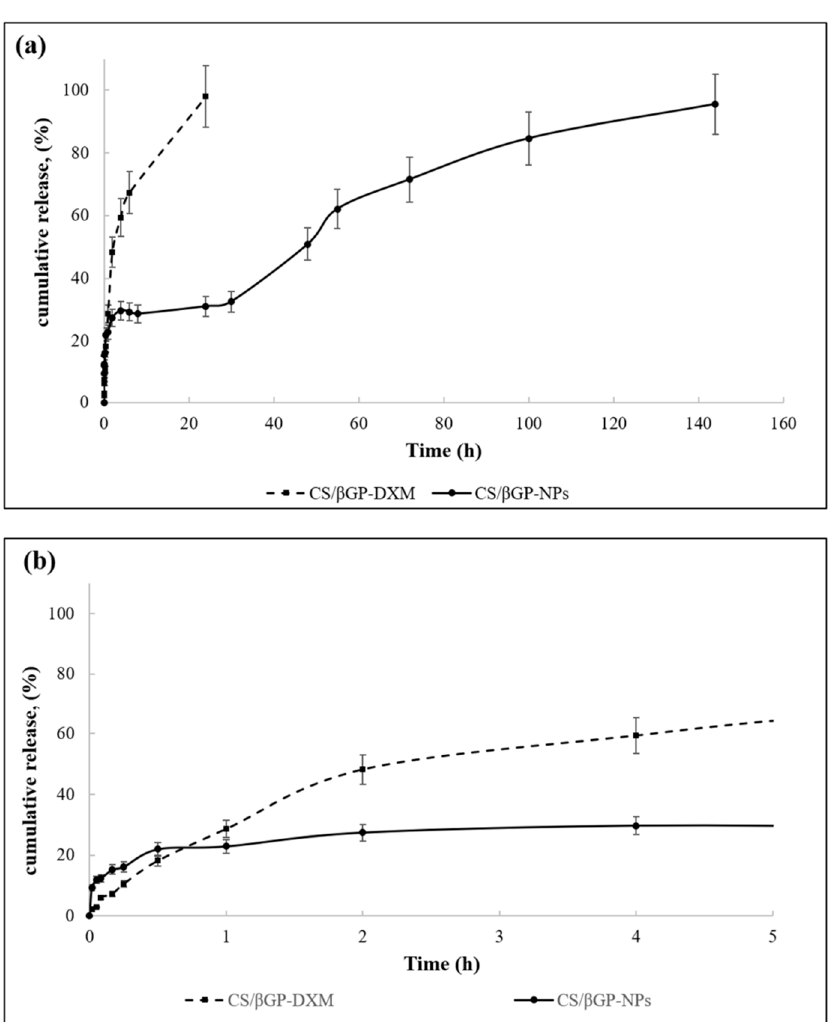
Figure 11. ( a ) DXM release profile from DXM loaded CS/ β GP (dotted line) and CS/ β GP-NPs (solid line) under simulated inflammatory pathological conditions (pH 7.0) at 37 °C until 140 h of incubation; and ( b ) focus on the first 5 h of incubation.